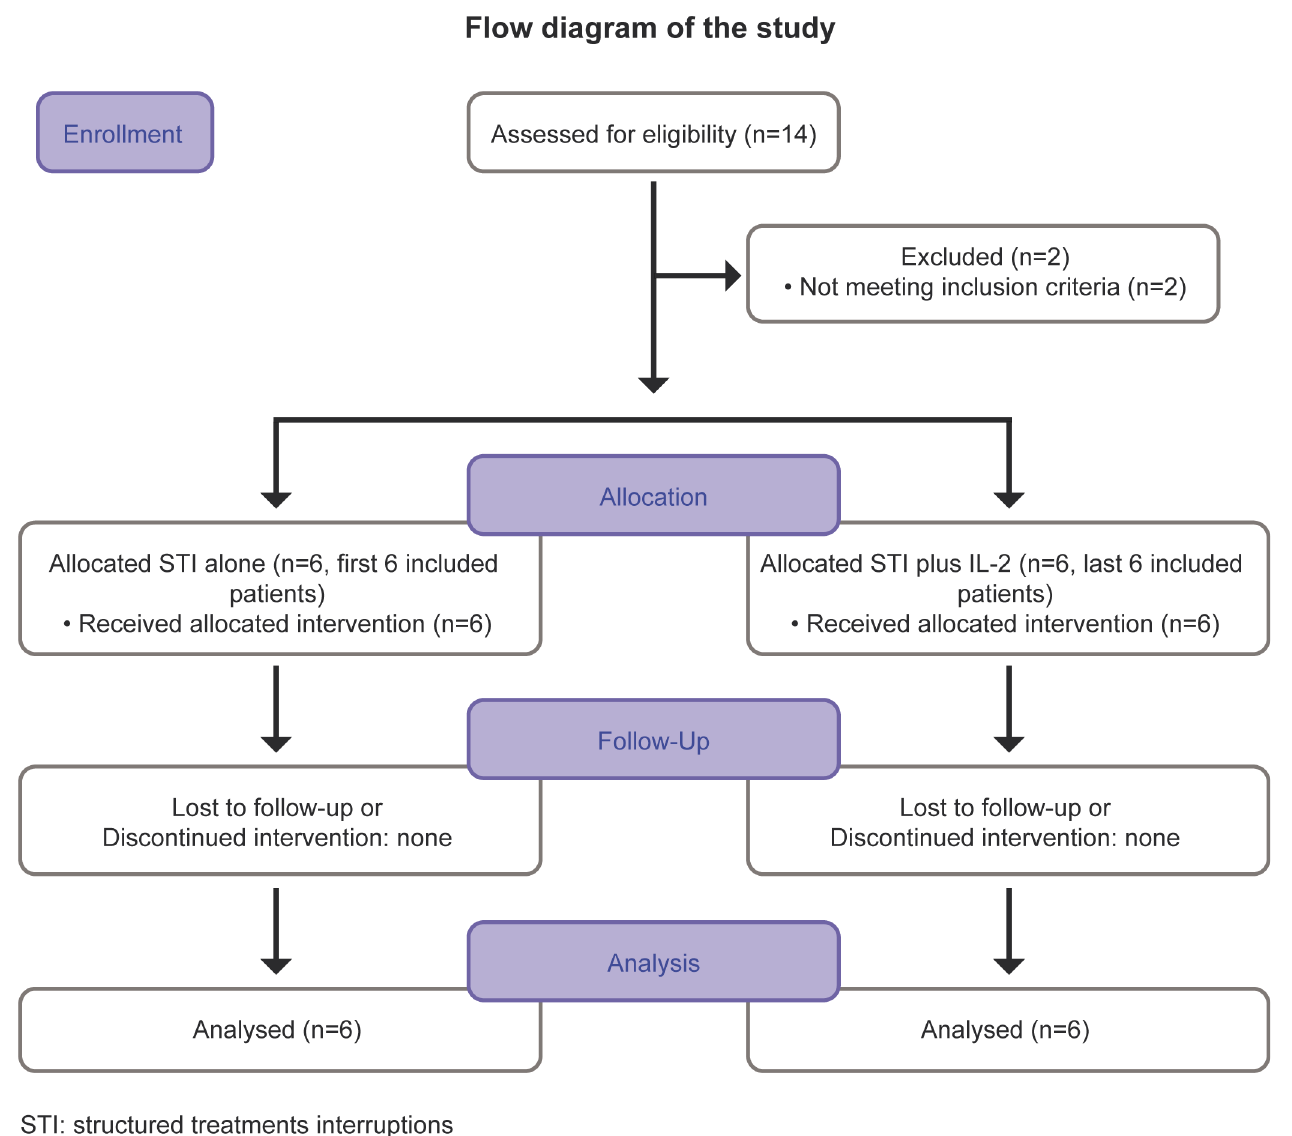
Fig 1. Flow diagram of the